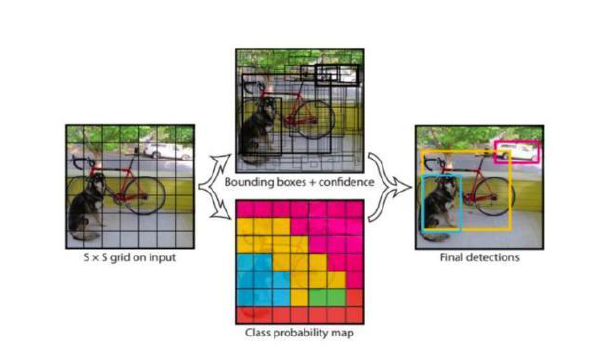
Figure 5. Process of object